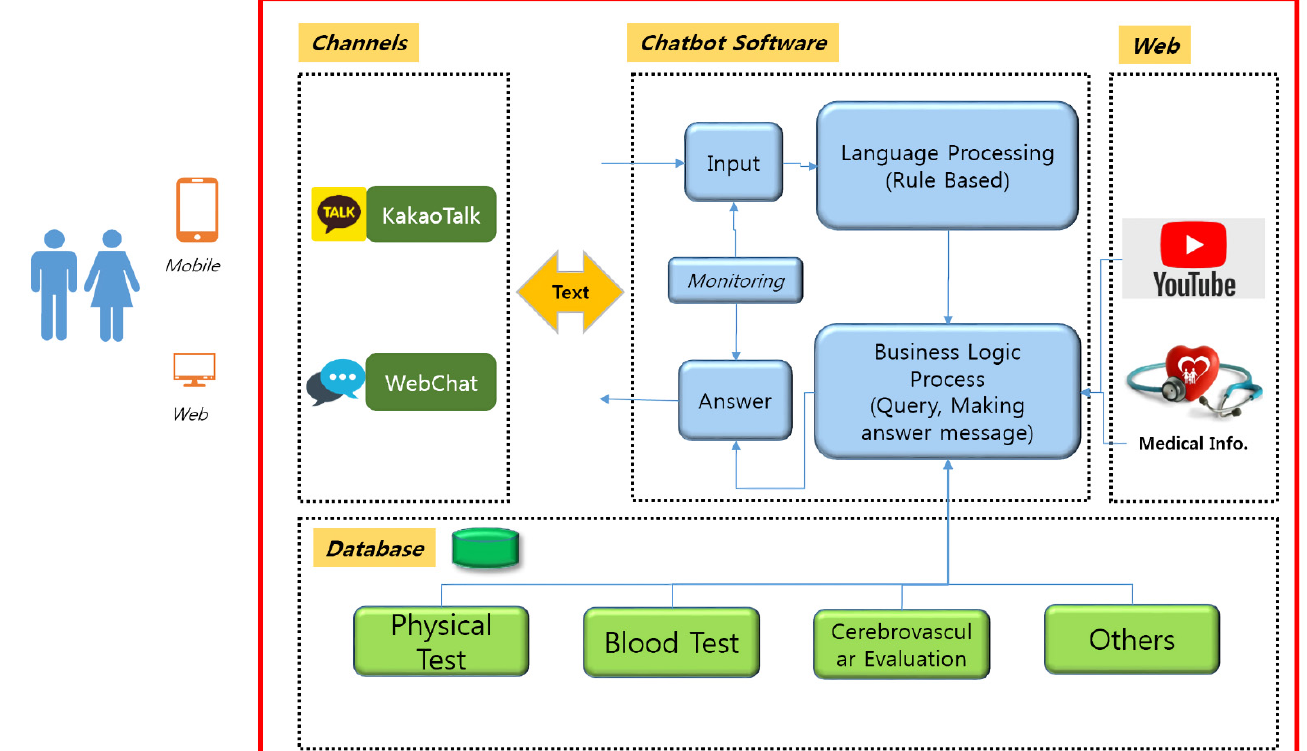
Figure 1. The overall system configuration of the chatbot program. Personal authentication is required only once, at the first access, and subsequent identification is automatic based on the phone number. After authentication, only the au- thenticated user’s information is displayed on the corresponding smartphone. Smartphone implementation is shown in Figure